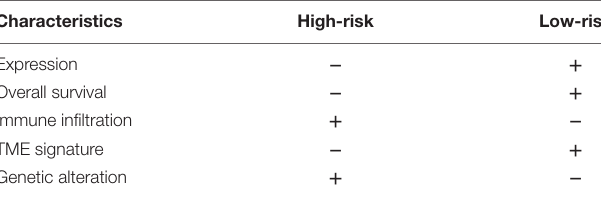
TABLE 2 | Summary of CXCL10-based